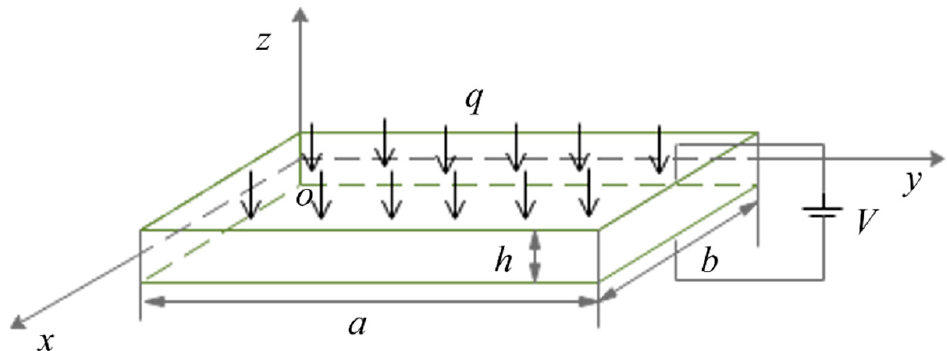
Figure 1. Coordinates, load, and applied voltage of thin piezoelectric plate.